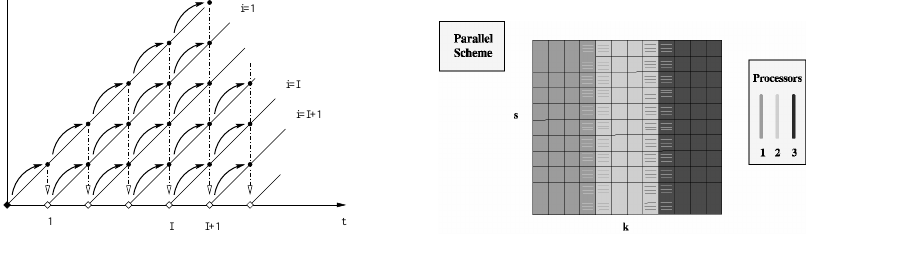
Figure 2. Schematic representation of the splitting of the computational load into three